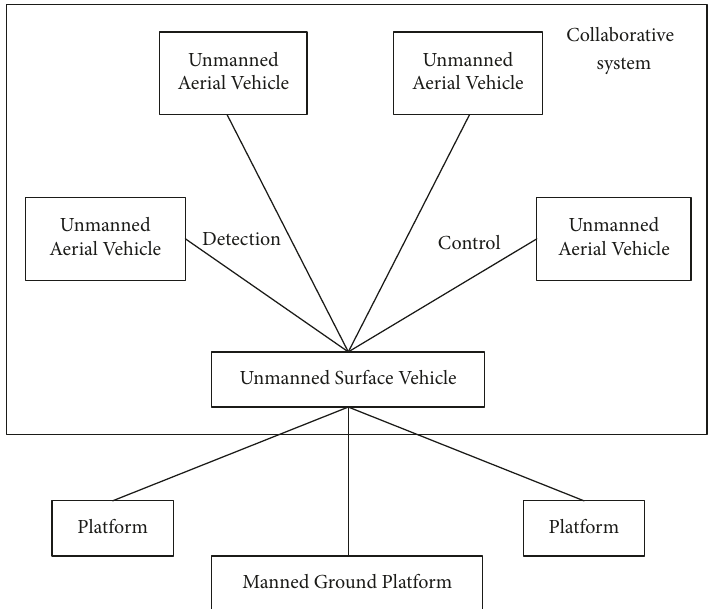
Figure 1: The model of USV-UAV(1,n) synergetic